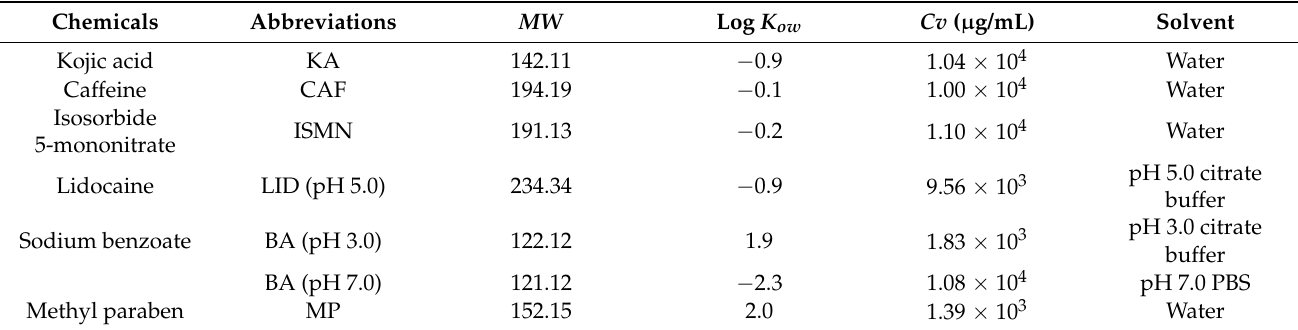
Table 1. Physicochemical properties of the examined target